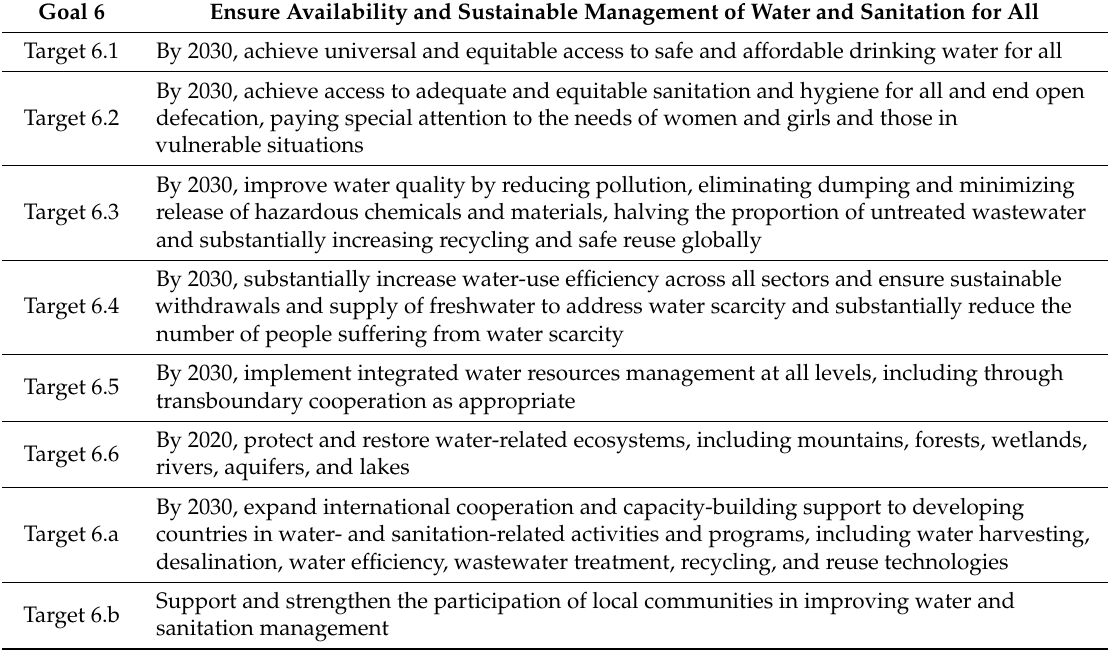
Table 1. The targets of Sustainable Development Goal 6. Source: UN General Assembly